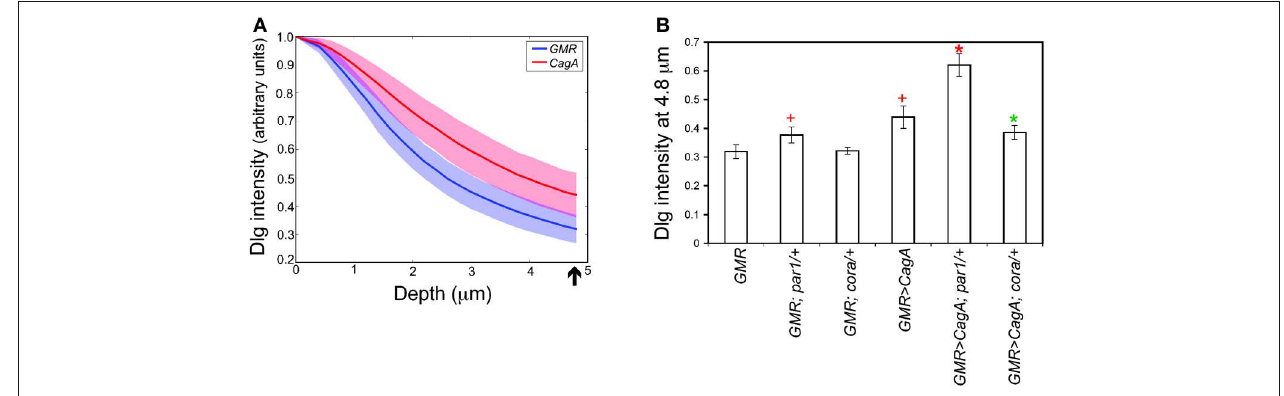
FIGURE 3 | (A) Pattern of Dlg staining in Z-stacks of larval retinal imaginal discs. CagA-expressing eye discs are compared to those expressing the GMR-Gal4 driver alone. Shaded areas represent standard error. The arrow